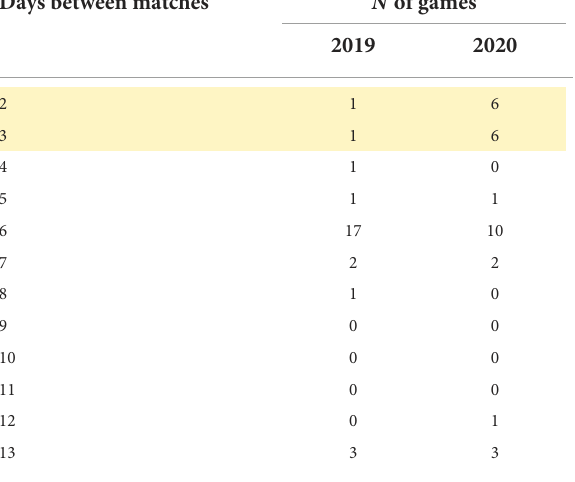
TABLE 1 Overview of recovery days between matches in the two